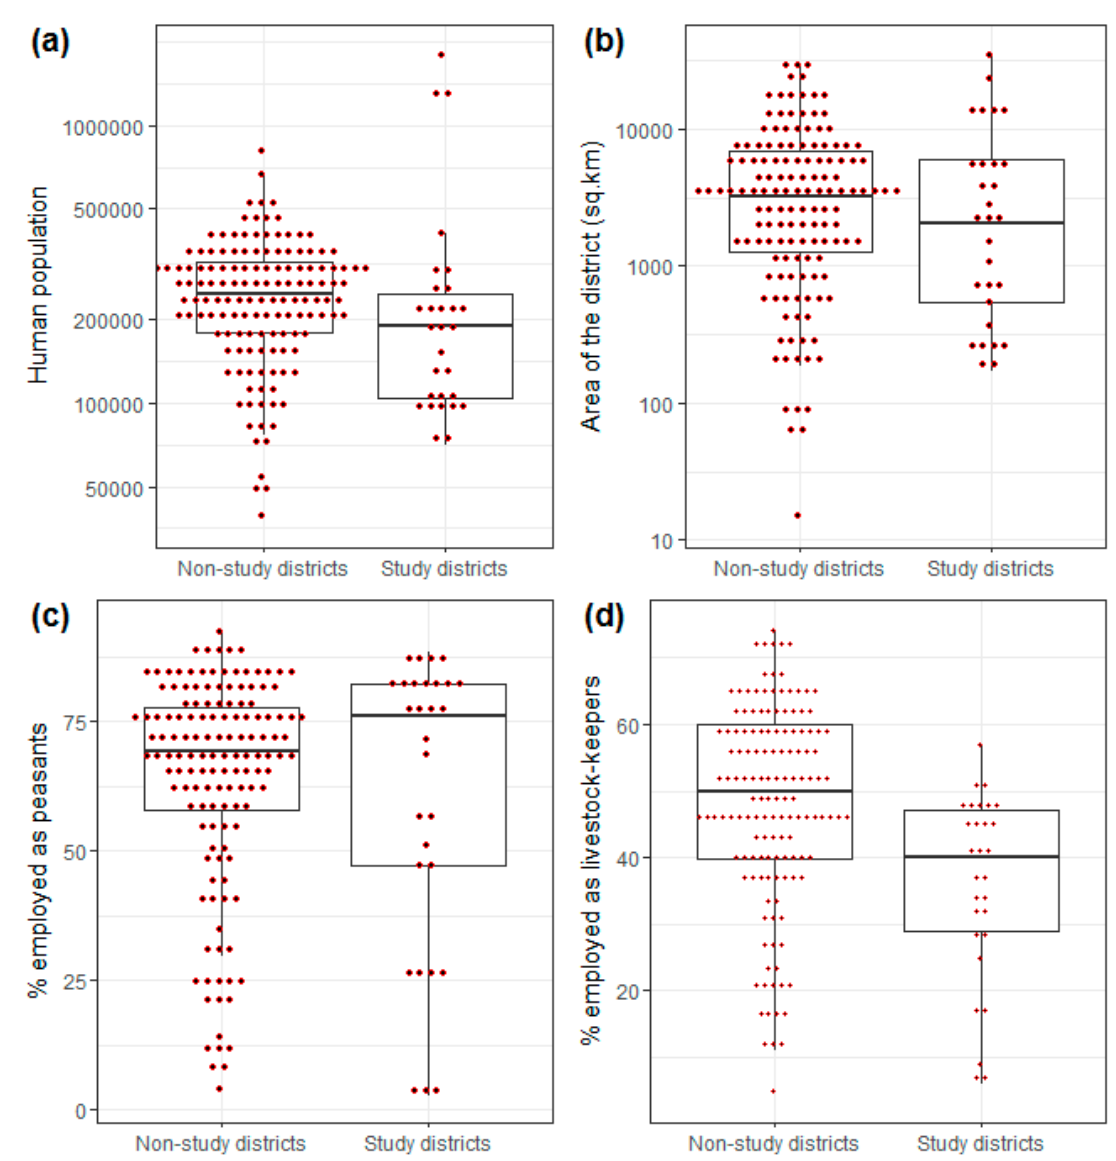
Figure A1. The distribution of the non-study districts and study districts in Tanzania. Red points represent data from each district. ( a ) Human population from the National census in 2012; ( b ) geographical area of the district in square kilometres; ( c ) percentage of population (aged >10 years and above) employed as peasants; and ( d ) percentage of population (aged >10 years and above) employed as livestock keepers.